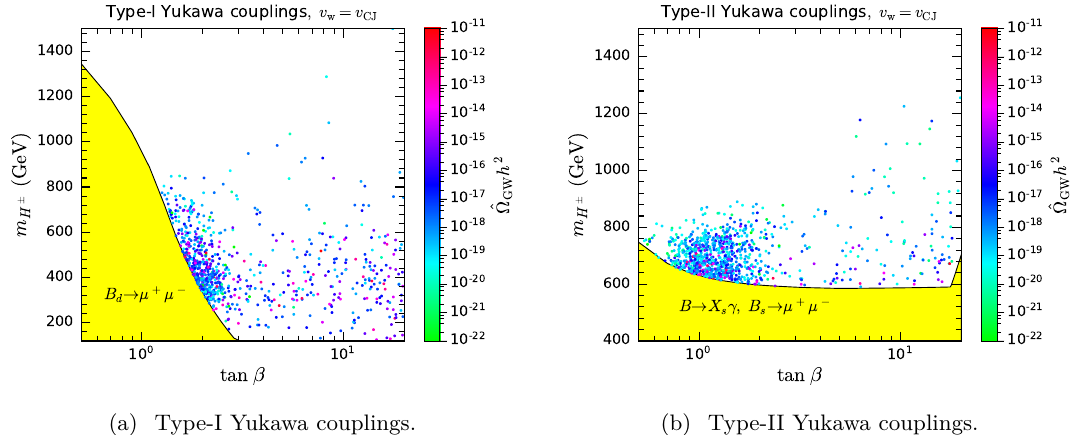
Figure 6 . Parameter points projected in the tan β - m ± couplings. Yellow regions are excluded at 95% C.L. by the FCNC bounds from the Gfitter global fit [73]. The color axes denote the peak amplitude of the GW spectrum ˆΩ GW h 2 for Jouguet